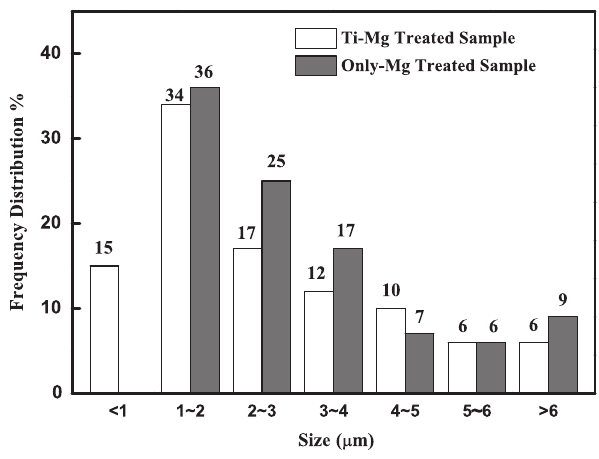
Figure 6: Size distribution of inclusions in sample 1 (Ti – Mg treated) and comparison sample B (only-Mg